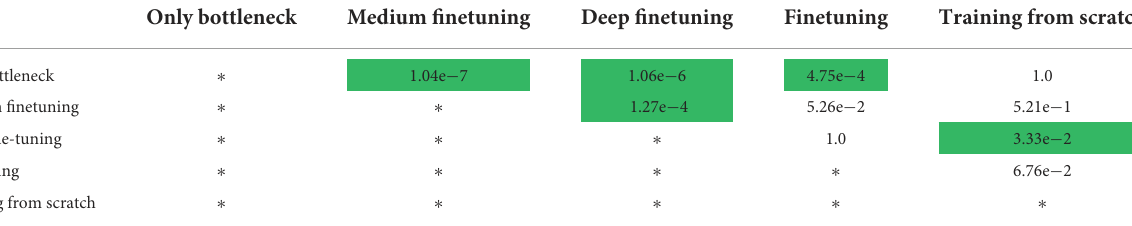
Only bottleneck ∗ 1.04e − 7 1.06e − 6 4.75e − 4 1.0 Medium finetuning ∗ ∗ 5.21e − 1 Deep fine-tuning Finetuning 6.76e − 2 Training from scratch ∗ ∗ ∗ ∗